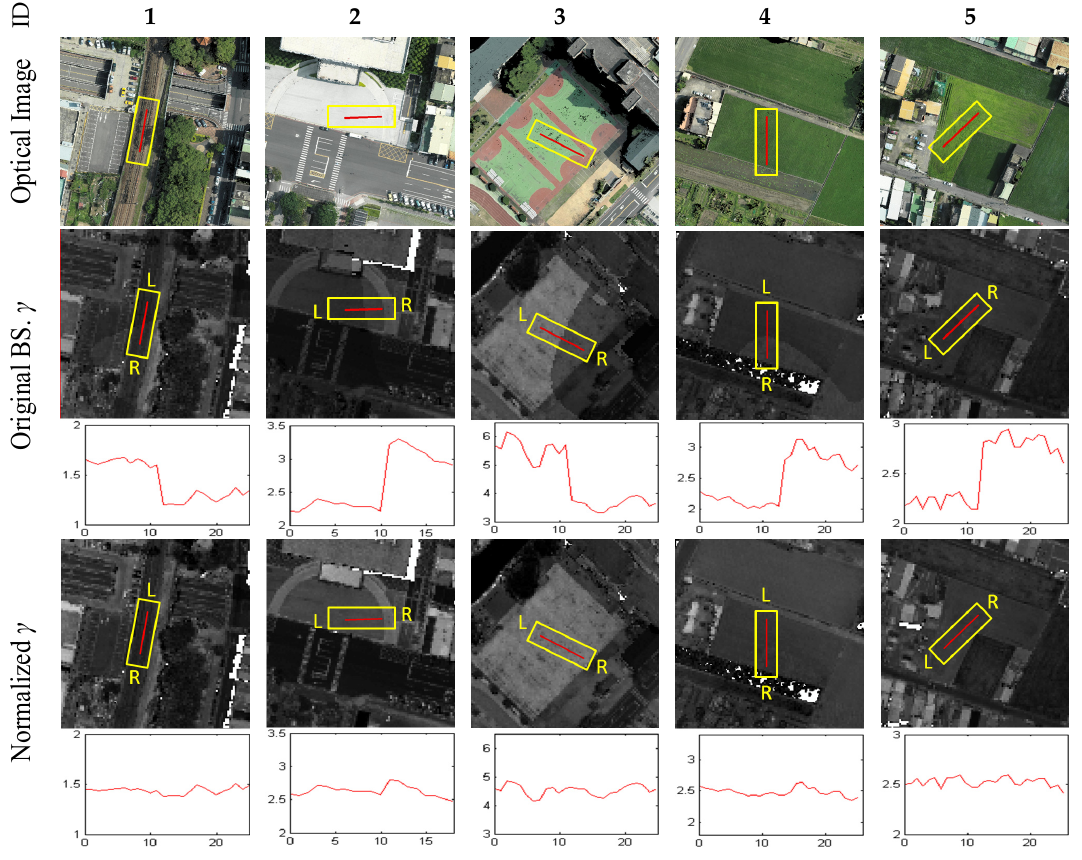
Figure 9. Profiles of check regions.